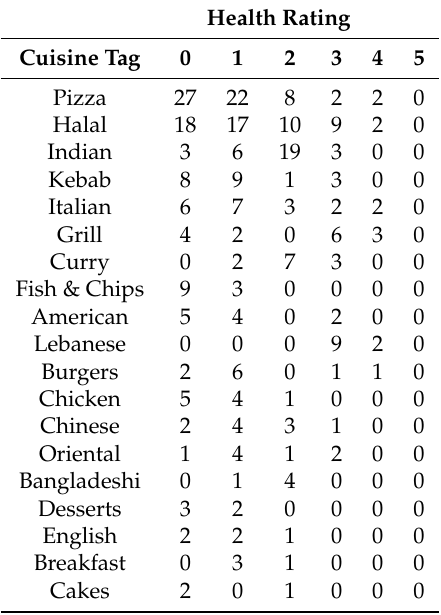
Figure 1. Frequency of takeaway outlets per each Health Rating score within the study sample. Table 4. Frequency of outlets for each assigned Health Rating by cuisine